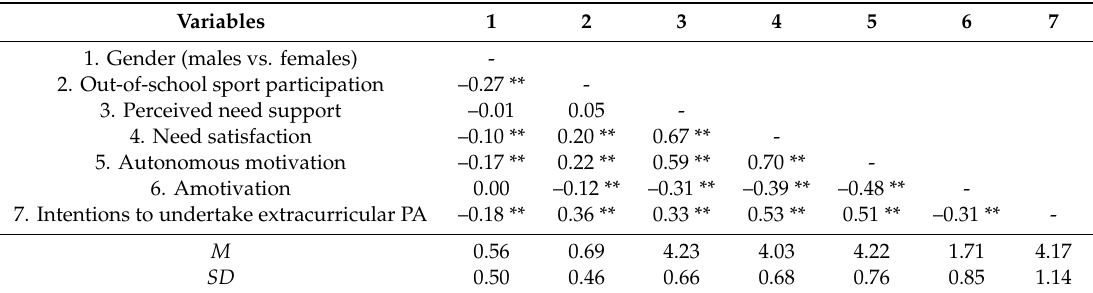
Table 1. Means, standard deviations, and bivariate correlations of the observed